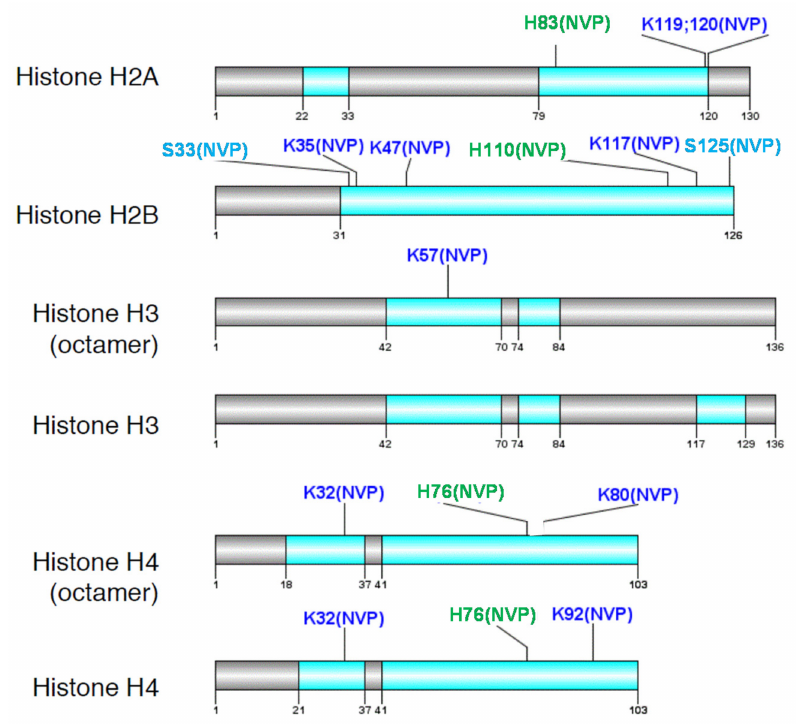
Figure 2. Overview of the H2A, H2B, H3, and H4 sequences showing the nevirapine-modified residues identified in this study. The amino acid number notation takes into account the first methionine, which is removed after protein synthesis. Regions of the sequence covered by MS analysis are represented in light blue; a gray shading represents non-covered